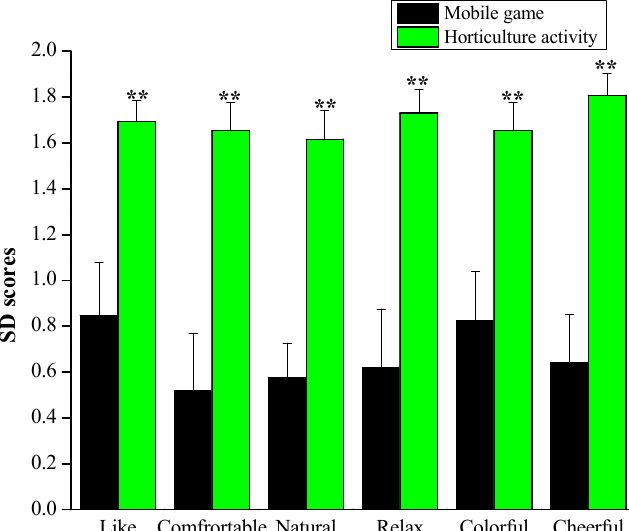
Figure 6. Comparison of the participants’ SD scores between horticultural and mobile game activities. n = 26, mean ± SE, ** p < 0.01 according to the Wilcoxon signed-rank test.